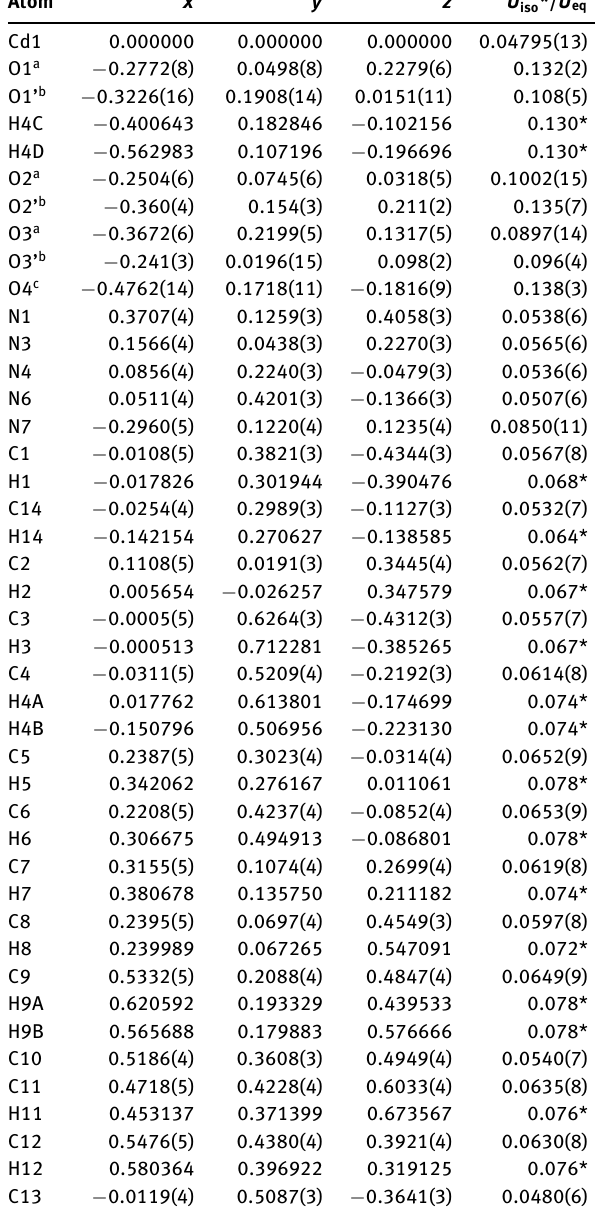
Table 2: Fractional atomic coordinates and isotropic or equivalent isotropic displacement parameters (Å 2